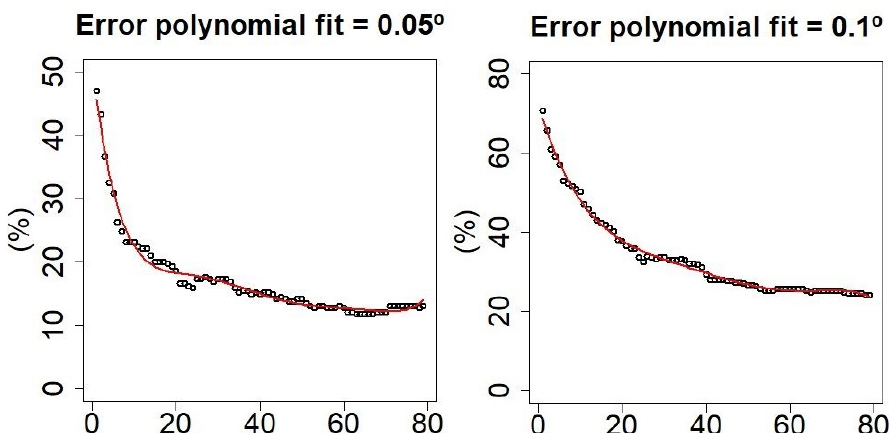
Figure 4. Board with thermal noise reduction in the progression of the algorithm with several confidence intervals from 0.05 ◦ C to 0.1 ◦ C. In the display board, the noise of the % in the temperature matrix is shown opposite the amount of steps. For every one of them, the permitted error range for the temperature collected by the IoT nodes is variable. As the allowable error range is increased, the thermal noise in the temperature matrix also is increased.